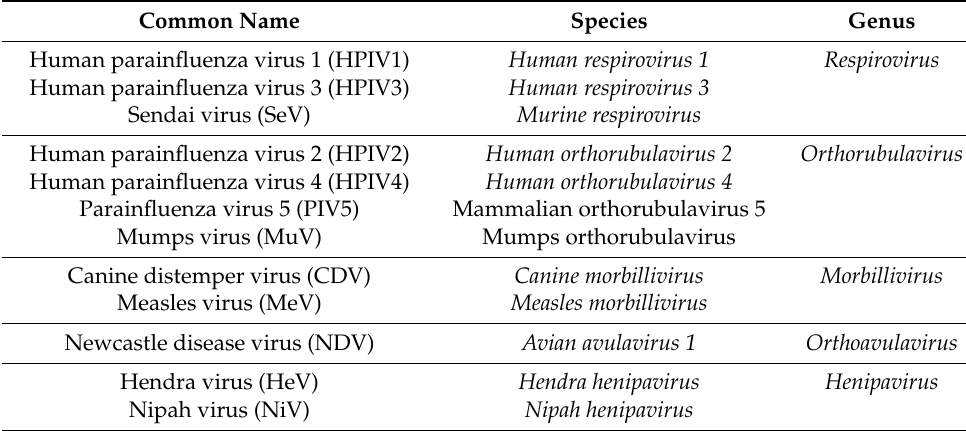
Table 1. Nomenclature of several viruses from Family